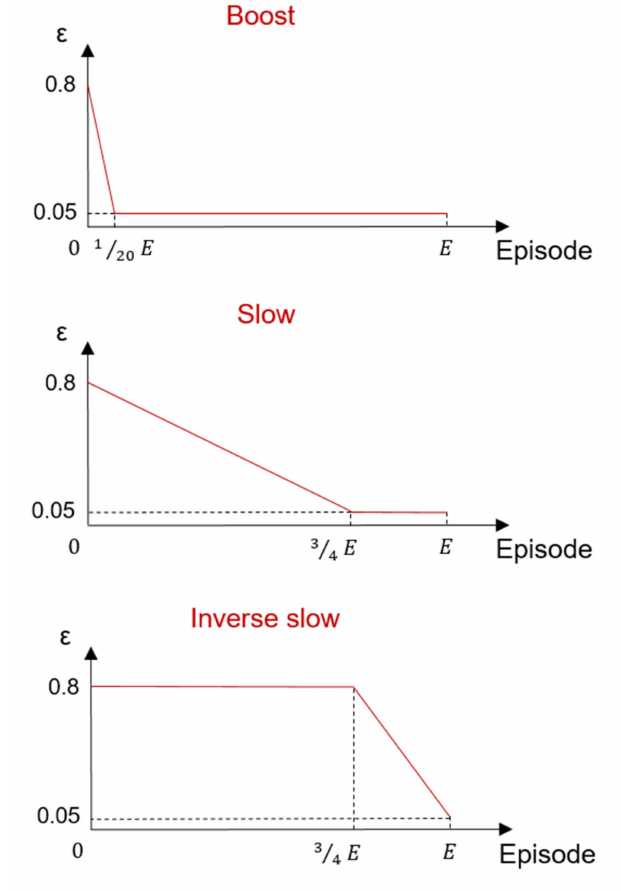
Figure 1. Three different exploration strategies for a Reinforcement Learning